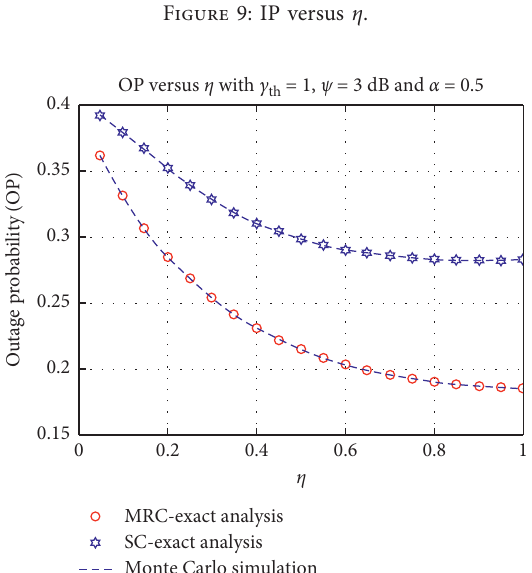
Figure 9: IP versus η .